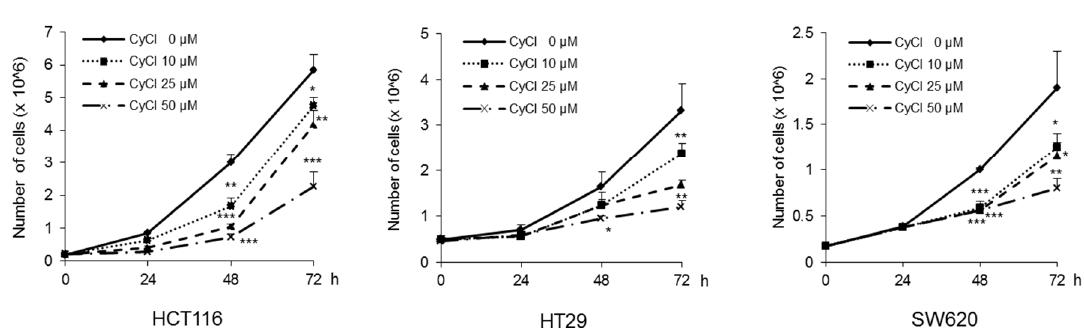
Figure 1. Cyanidin chloride (CyCl) inhibits cell proliferation in colon cancer cell lines. The antitumor effect of CyCl on HCT116, HT29, and SW620 cells was measured by trypan blue staining. Cells were treated with 0, 10, 25, and 50 µM of CyCl for 24, 48, and 72 h. Each experiment was performed in triplicate. * p < 0.05, ** p < 0.01, and *** p < 0.001, significantly different compared with control.